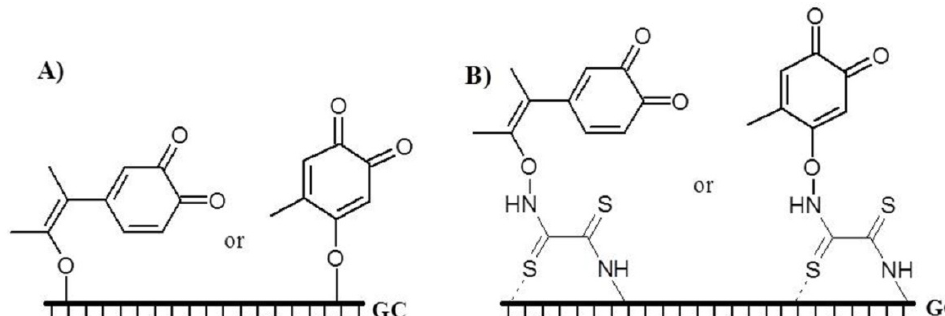
Figure 7. Grafting QR onto the ( A ) bare GC and ( B ) DTO/GC electrode